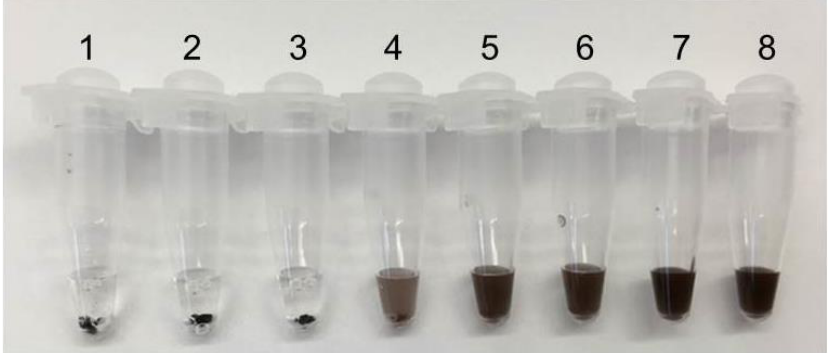
Figure 5. Limits of detection. Numbers 1~8 represent simulated probe concentrations of 1 µM, 100 nM, 10 nM, 1 nM, 100 pM, 10 pM, 1 pM and negative control.